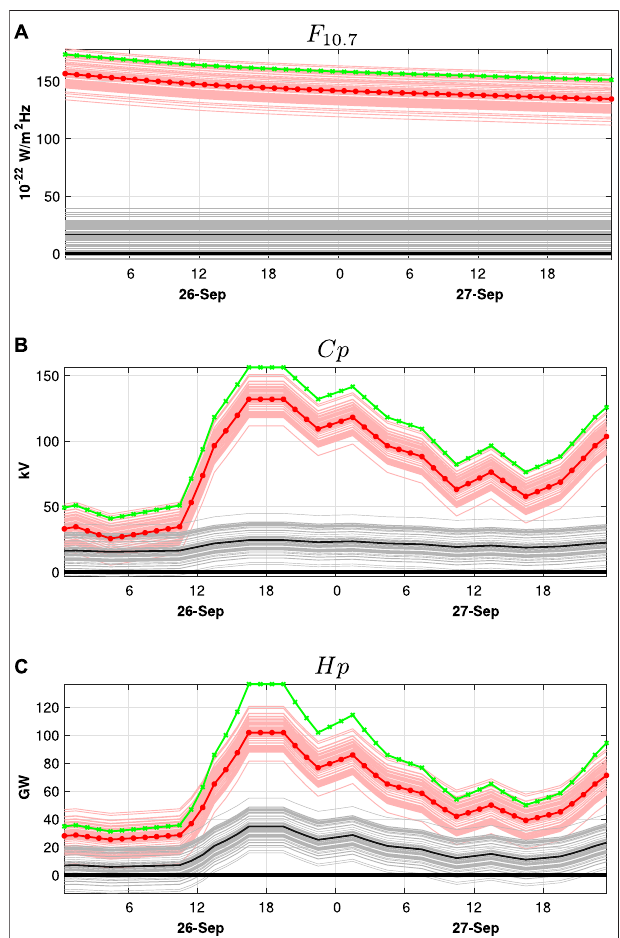
FIGURE 1 | (A) Time series of F 10 . 7 indices in solar fl ux units ( 10 − 22 W / ( m 2 Hz )) , (B) cross-tail potential ( Cp ) in kV, and (C) hemispheric power ( Hp ) in GW. The horizontal axis is in hours, starting at 00:30 UTC on 26 September and ending at 23:30 UTC on September 27, 2011. The parametersusedtodrivethetruthareshowningreen,theparametersusedto drive the ensemble of forecasts are shown in pink and their respective ensemble means are shown in red. The deviation of each parameter from those used in the control simulation is shown in gray, and the ensemble mean of the deviations is shown in